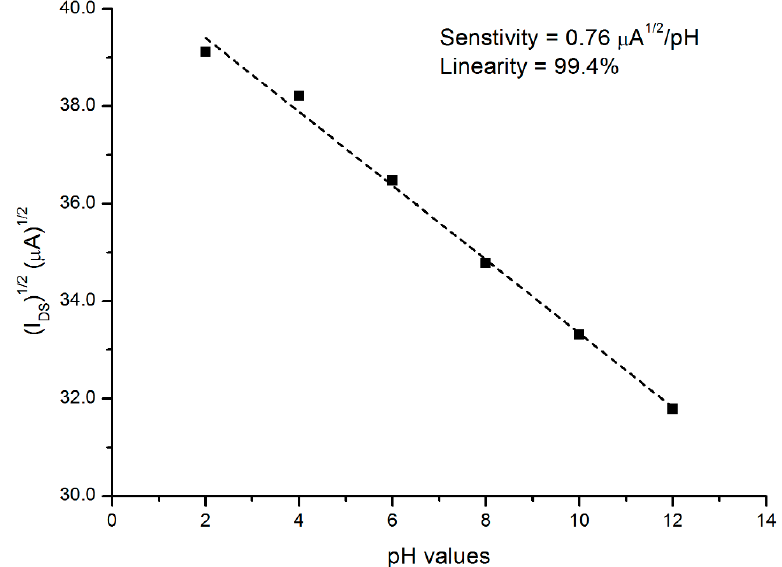
Figure 8. Plot of the √I DS as a function of pH for the prepared PSi pH sensor. V DS and V REF = 3 V. Black squares are measured data, and dashed line shows linear fit. Table 1. The pH current sensitivity for various materials.